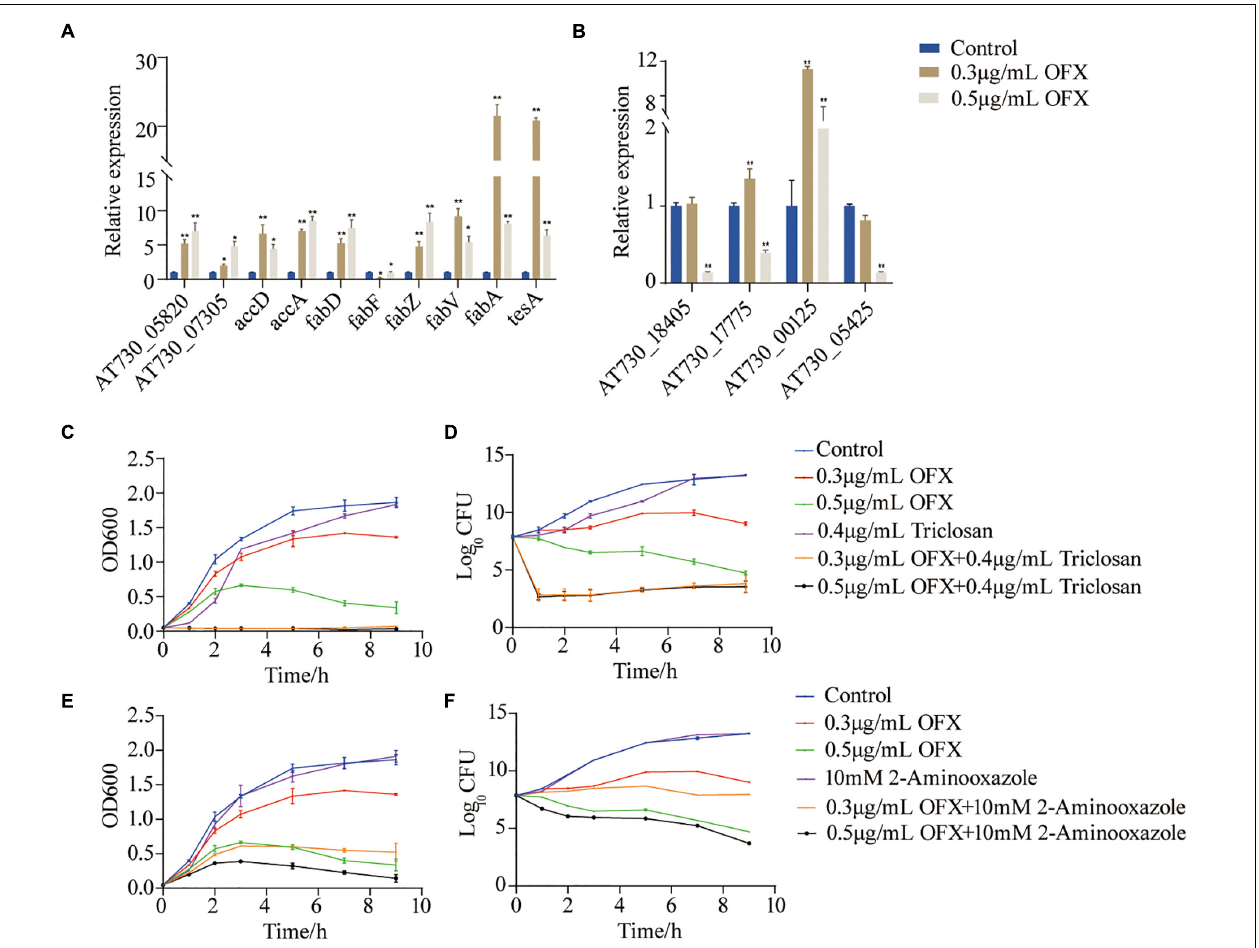
FIGURE 7 | Fatty acid synthesis is a survival factor under OFX stress (A) Quantification of gene expression of fatty acid treated by indicated concentrations of OFX for 2 h. (B) Quantification of gene expression of unsaturated fatty acids treated by indicated concentrations of OFX for 2 h. (C) Growth curve of V. alginolyticus in medium with the indicated concentrations of OFX or 0.4 µ g/ml triclosan. (D) CFU of (C) . (E) Growth curve of V. alginolyticus in medium with the indicated concentrations of OFX or 10 mM 2-aminooxazole. (F) CFU of (E) . The statistical analyses were performed with Mann–Whitney U -test unless otherwise indicated. * P <0.05; ** P <0.01. Error bars represent means ± standard errors of the means (SEM). All of the experiments were repeated at least three